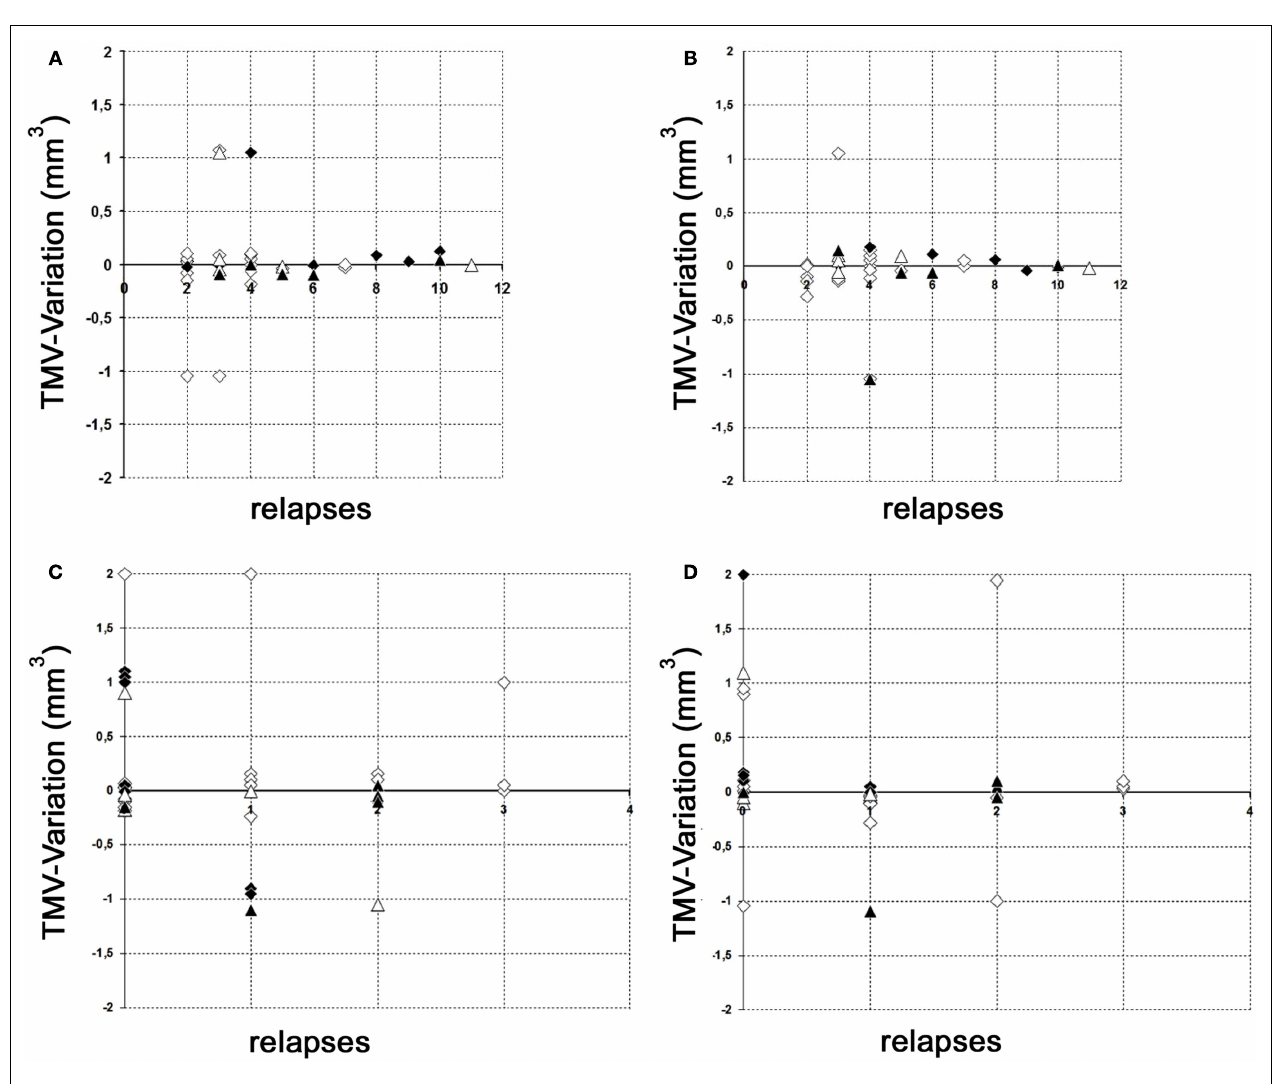
relapses (without ON) during the observation period. (A) Left eye; (B) right eye; (C) left eye; (D) right eye; white squares, RRMS without ON; black squares, RRMS with ON; white triangles, SPMS without ON; black triangles, SPMS with